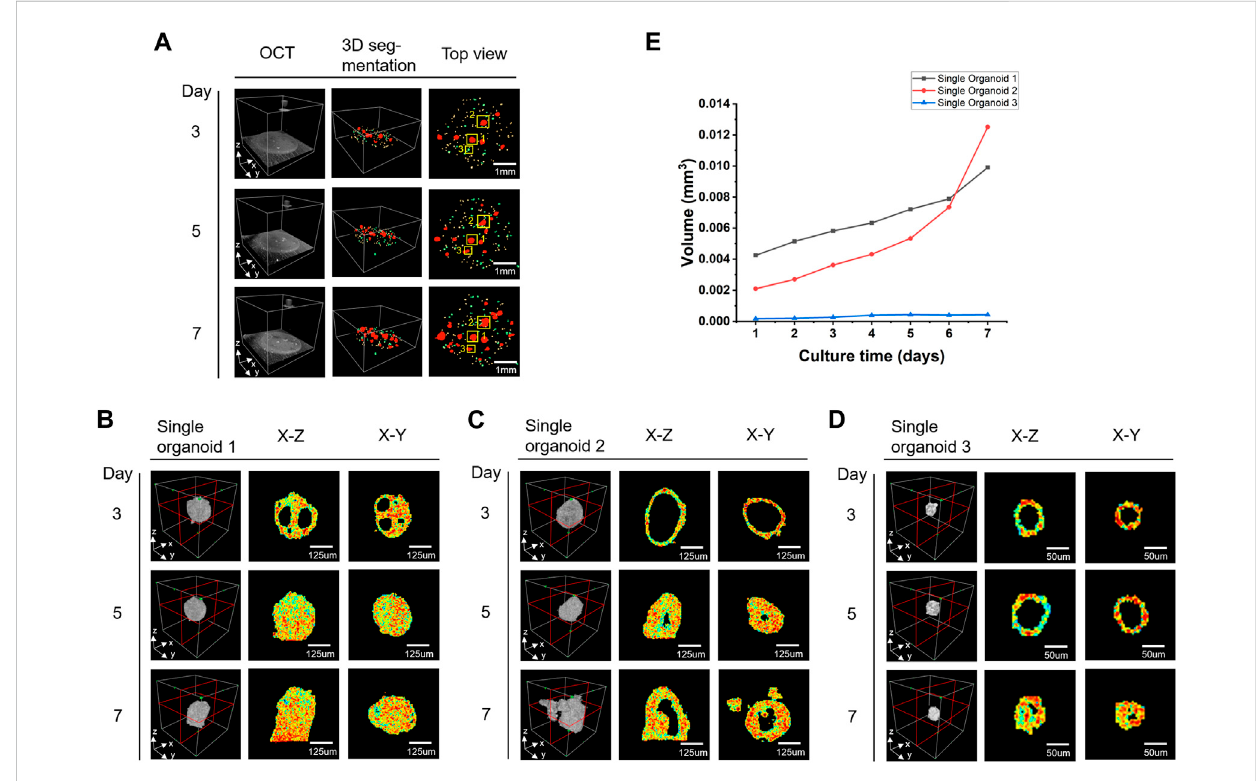
FIGURE 5 Shape and size changes of colon cancer organoids during the monitoring period. (A) Colon cancer organoids at different time points. From left to right are 3D OCT images, 3D segmentation results and the top views. Different diameters of organoids are marked with different colors (yellow:50 μ m